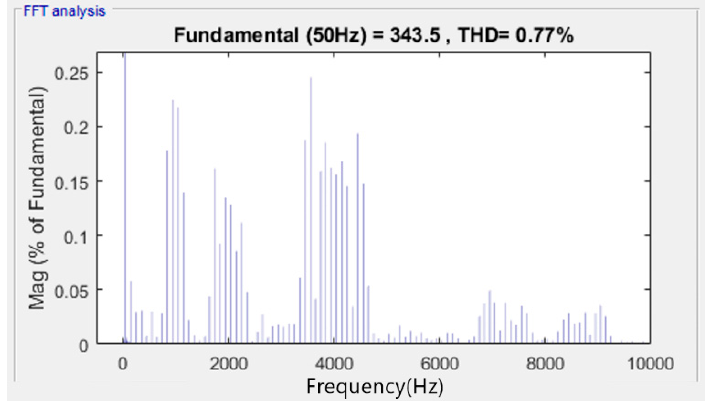
Figure 9. Four H-bridge CHB THD for PS PWM and non-equal sources best switching sequence 1423.